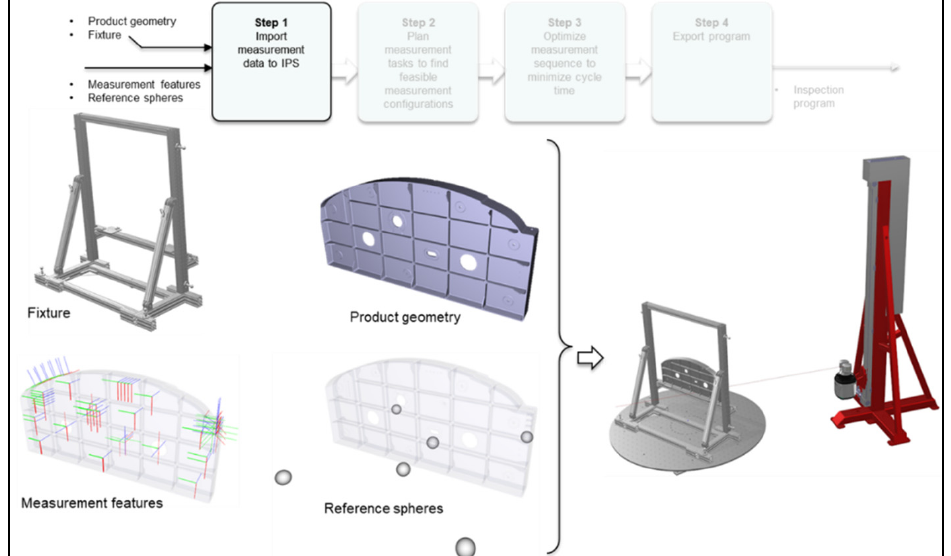
Figure 31. The evolved IPS laser radar process overview.